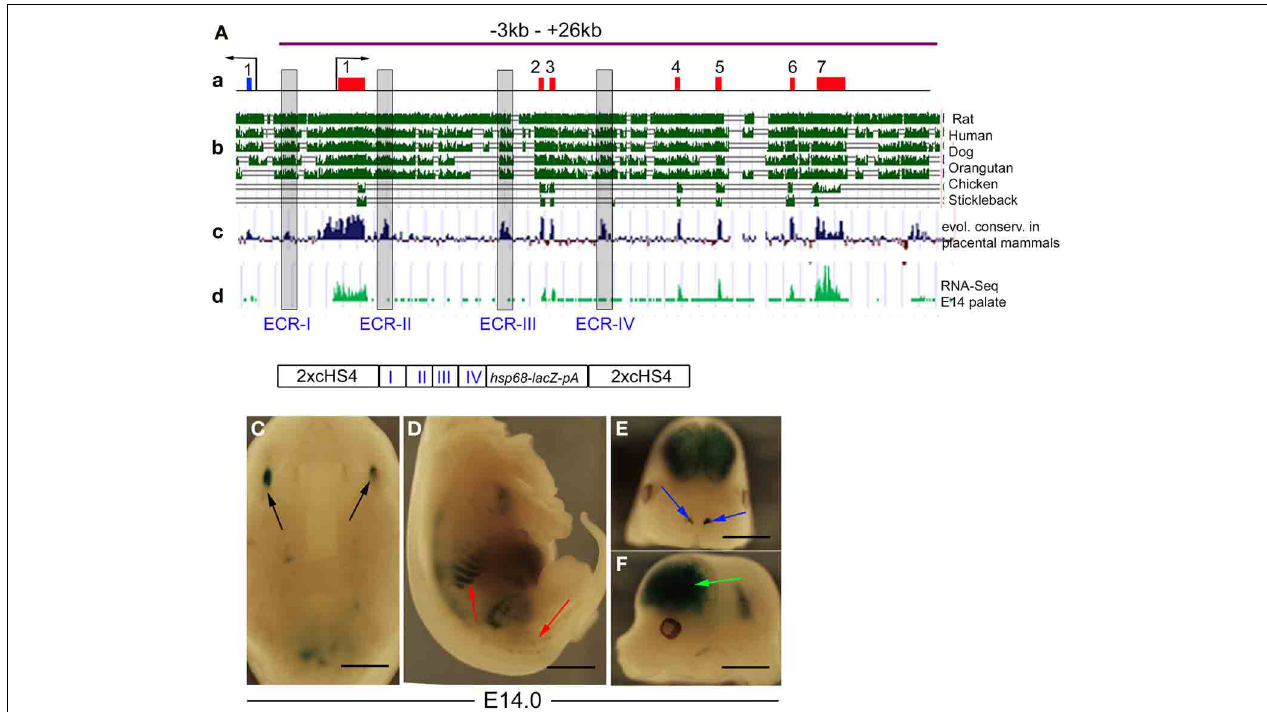
FIGURE 5 | Evolutionarily conserved regions within the Tgfb3 gene do not direct reporter expression in palatal shelves. (A) Schematic representation (a) of the Tgfb3 gene (red boxes depict Tgfb3 exons 1–7; blue box depicts Ift43 exon 1; black arrows show the TSSs for Tgfb3 and Ift43 ) aligned with graphs of evolutionary sequence conservation among selected vertebrate species ( b , UCSC genome browser), among placental mammals ( c , UCSC genome browser) and RNA-seq profile in mouse palate at E14.5 ( d , FaceBase Enhancer Project; A Visel) used to identify non-coding, evolutionarily conserved